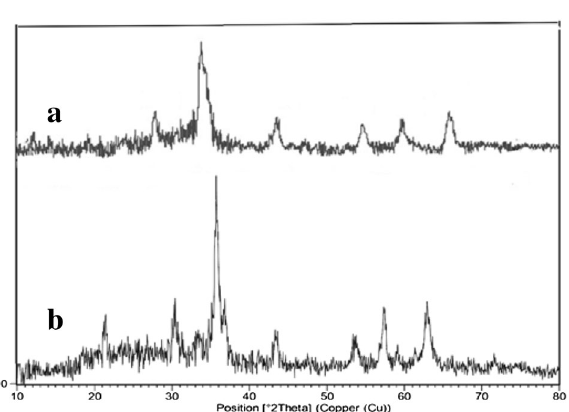
Figure 4. XRD patterns of ( a ) Fe 3 O 4 NPs, and ( b )